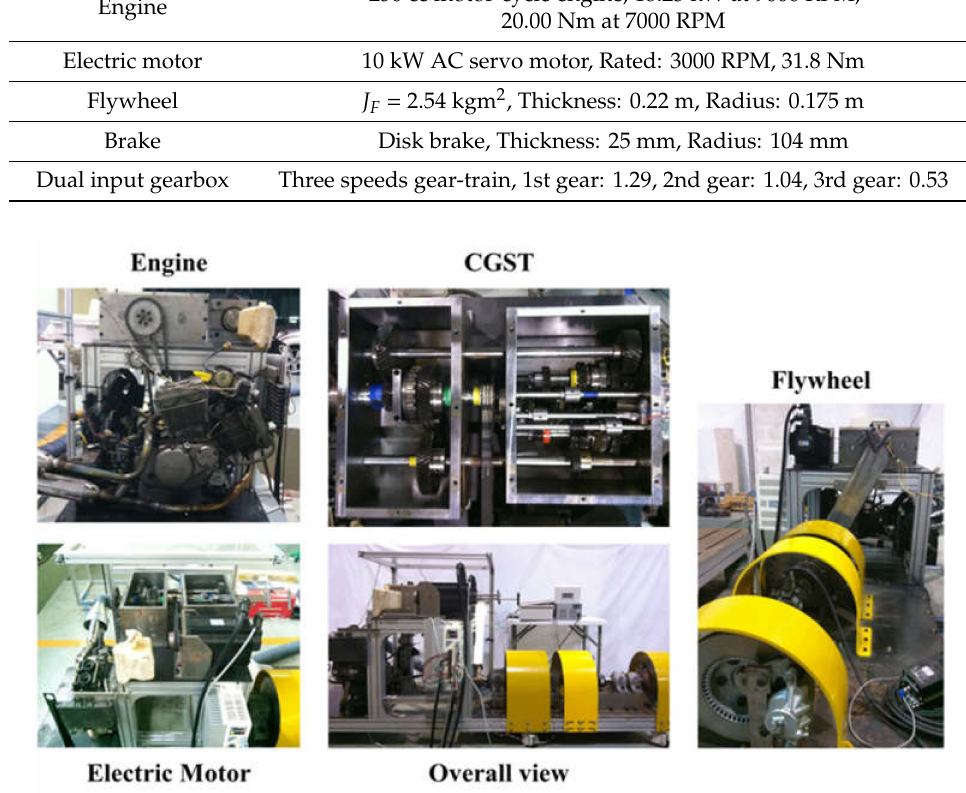
Figure 8. Pictures of the developed test-rig.